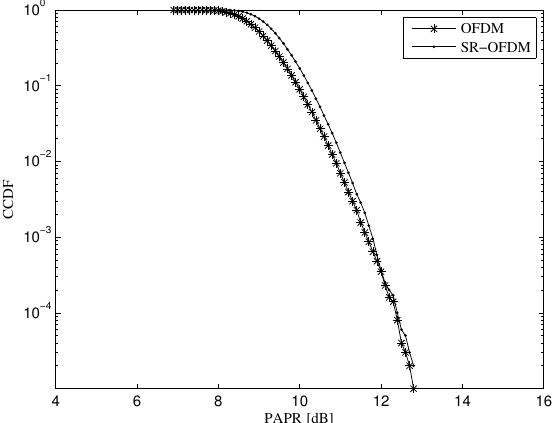
Figure 9. PAPR comparison between the classical OFDM and the proposed SR-OFDM.